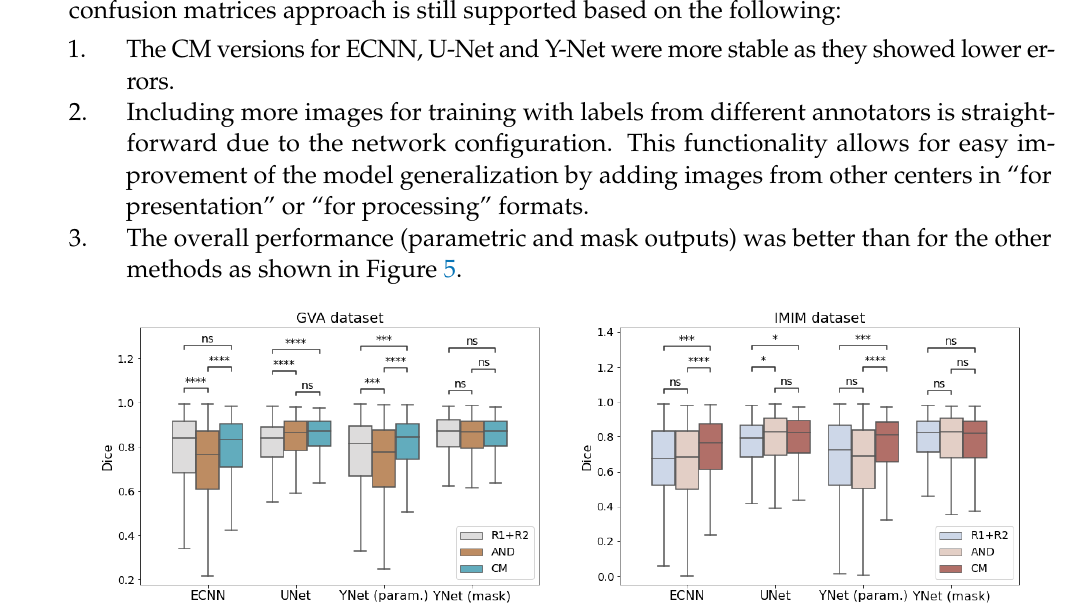
Figure 4. Comparison of models trained with different strategies (R1 + R2, AND mask and confusion matrices (CM)). ns: not significant, *: p ≤ 0.05, ***: p ≤ 0.001, ****: p ≤ 0.0001.